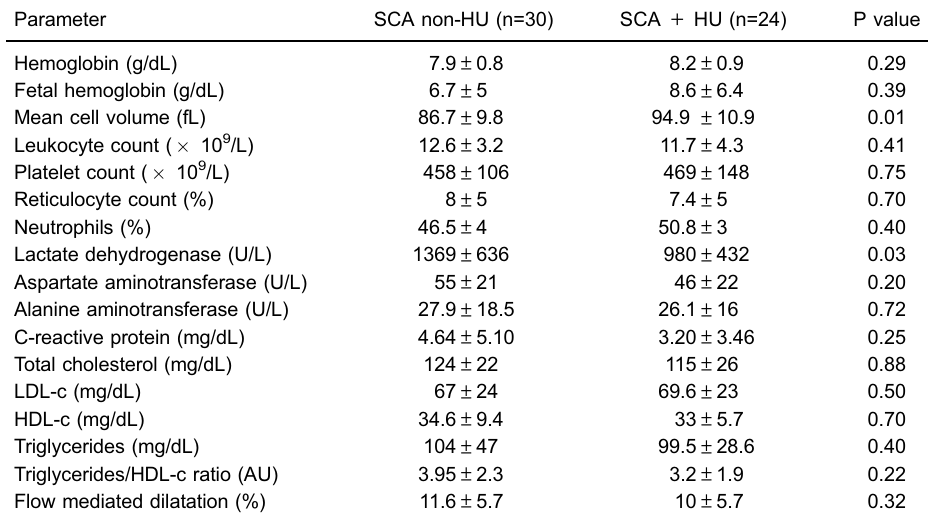
Table 5. Characteristics of sickle cell anemia (SCA) patients strati fi ed by hydroxyurea (HU) treatment